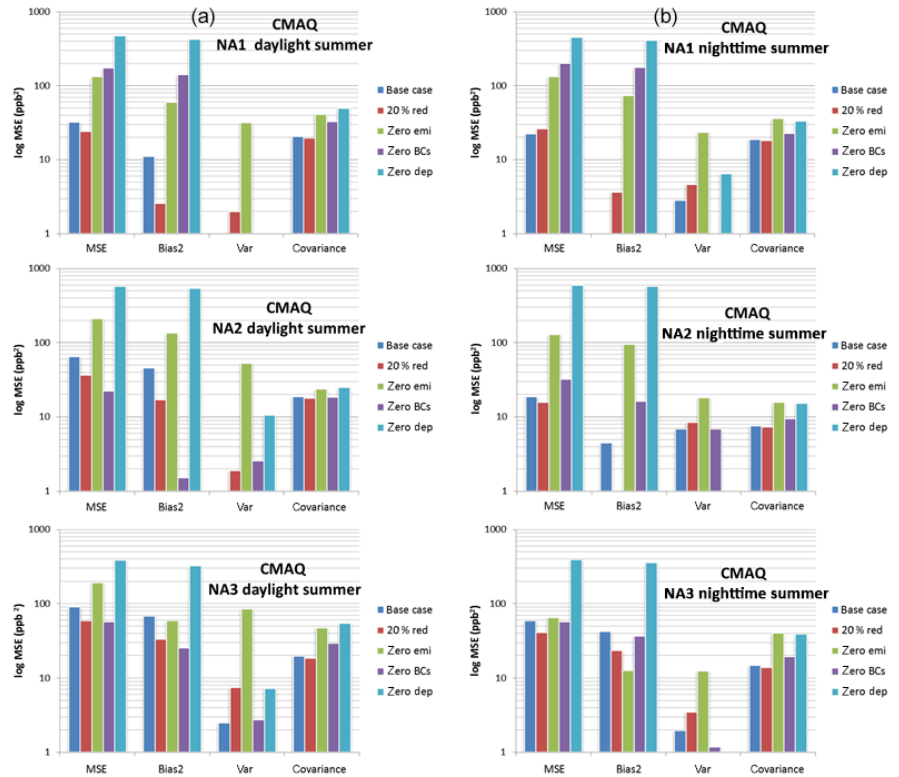
Figure 4. MSE decomposition for June–August hourly ozone into bias, variance, and covariance for the three North American (NA) subre- gions. Results are presented separately for daylight hours (a) and nighttime hours (b)